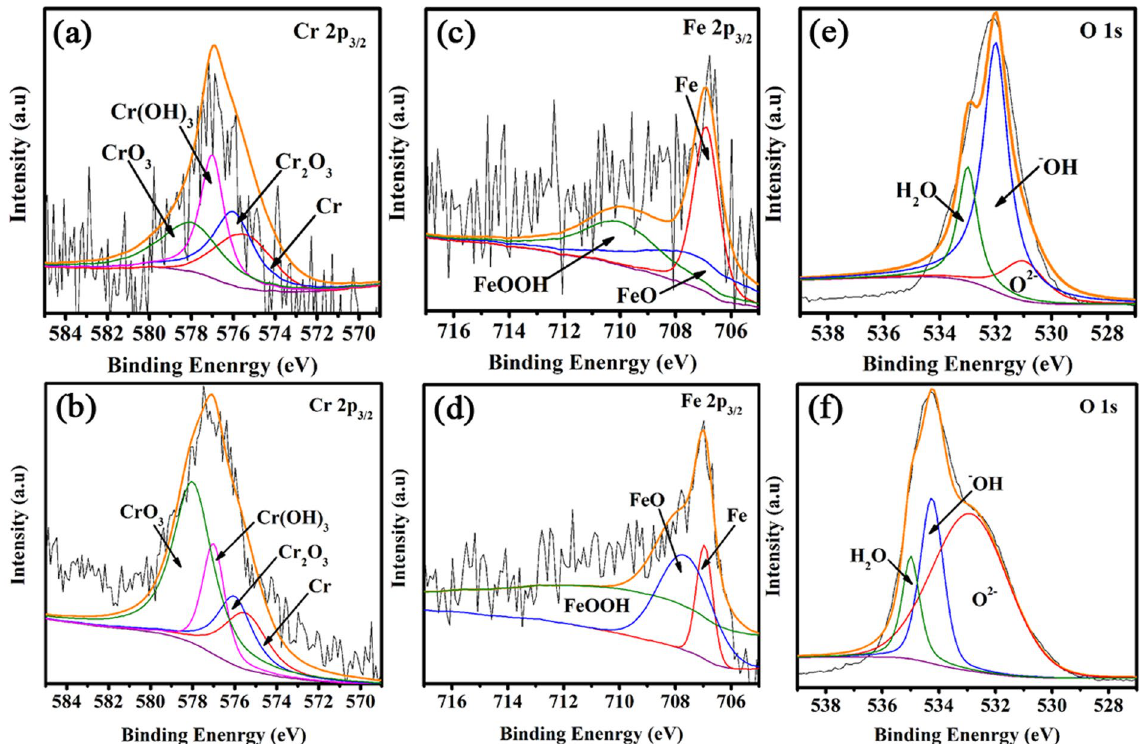
Figure 3. Cr2p3/2, Fe2p3/2, O1s XPS spectra of PDDA/PSC ( a , c , e) and PSC/TMS-SiO 2 coating ( b , d , f ). To analyze different ionic states, the corresponding elemental fitting of Cr, Fe and O elements were performed as represented by orange